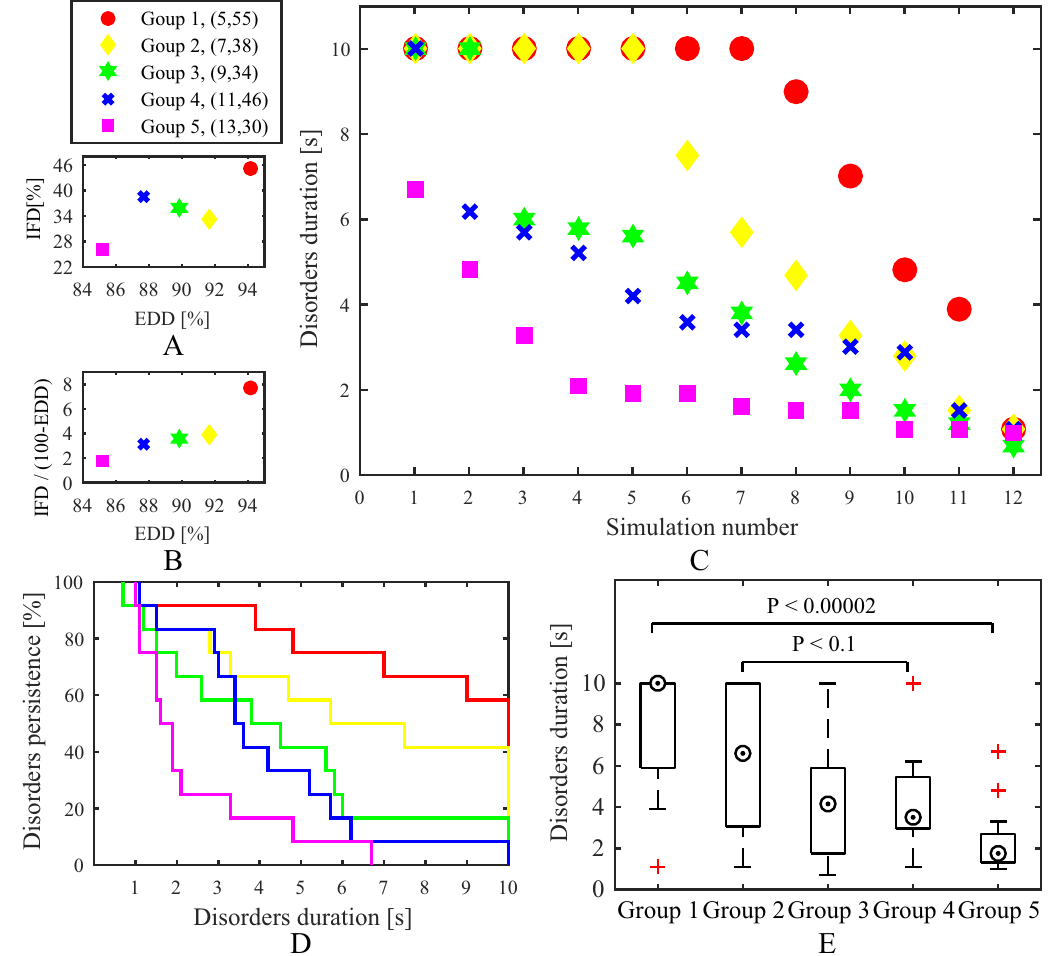
Fig 8. Simulation results of the fibrosis-degree-controlled groups. (A) and (B) Distributions of average of intramural fibrosis degree and endo-epicardial dissociation degree for all simulations in each group. (C) A time distribution for all simulations. (D) Kaplan- Meier curves and (E) boxplots show effects of intramural fibrosis and endo-epicardial dissociation on stability. IFD is the intramural fibrosis degree and EDD is the endo-epicardial dissociation degree.